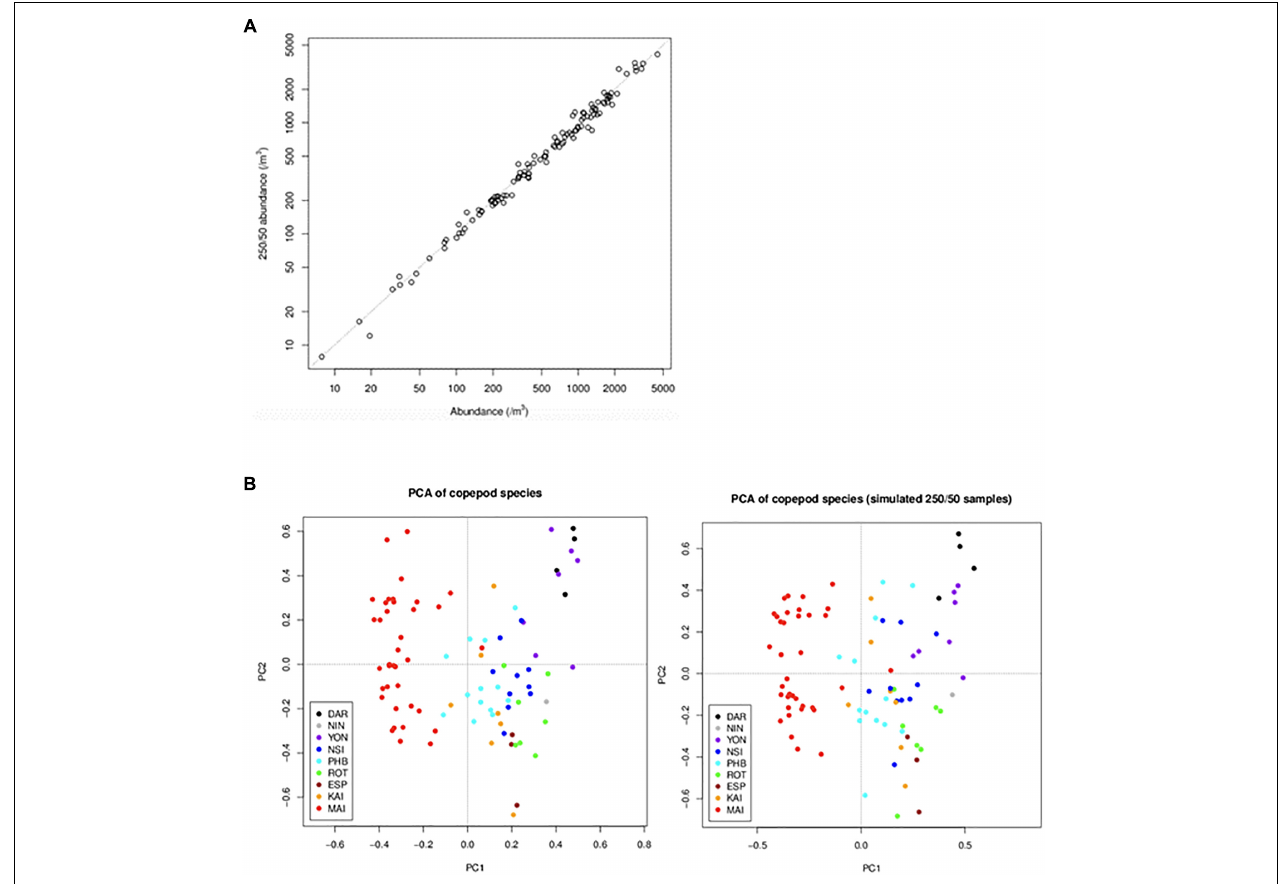
FIGURE 7 | Comparison of data obtained under the initial and revised counting rules. Data obtained under the new rules (250 individuals/50 adults) were simulated from data obtained under the old rules (500/100). To simulate the new-rule data for a sample, we selected a subset of the sample’s subsamples that was consistent with the new rules. The graphs compare data from the old and new rules in terms of (A) copepod abundance (the dotted line is the 1:1 line) and (B) copepod community composition (summarised by principal components analysis of copepod species) (DAR = Darwin, ESP = Esperance, KAI = Kangaroo Island, MAI = Maria Island, NIN = Ningaloo, NSI = North Stradbroke Island, PHB = Port Hacking, ROT = Rottnest Island, YON =